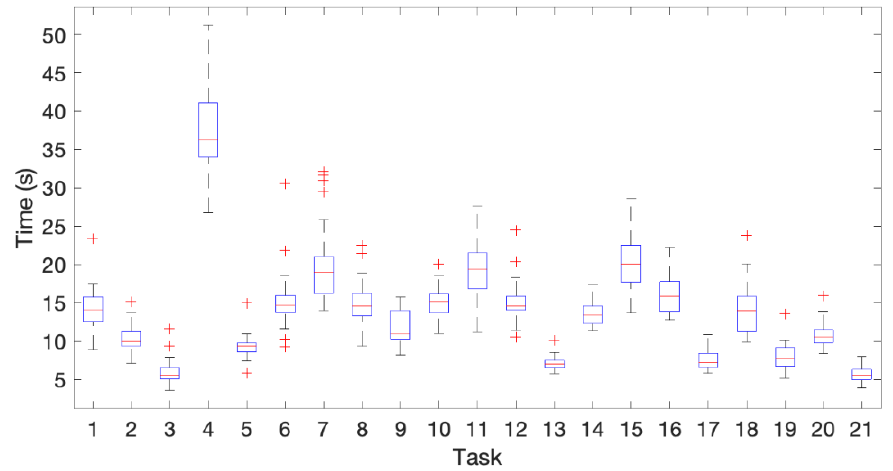
Figure 6. Boxplot of time spent in the execution of the different tasks.